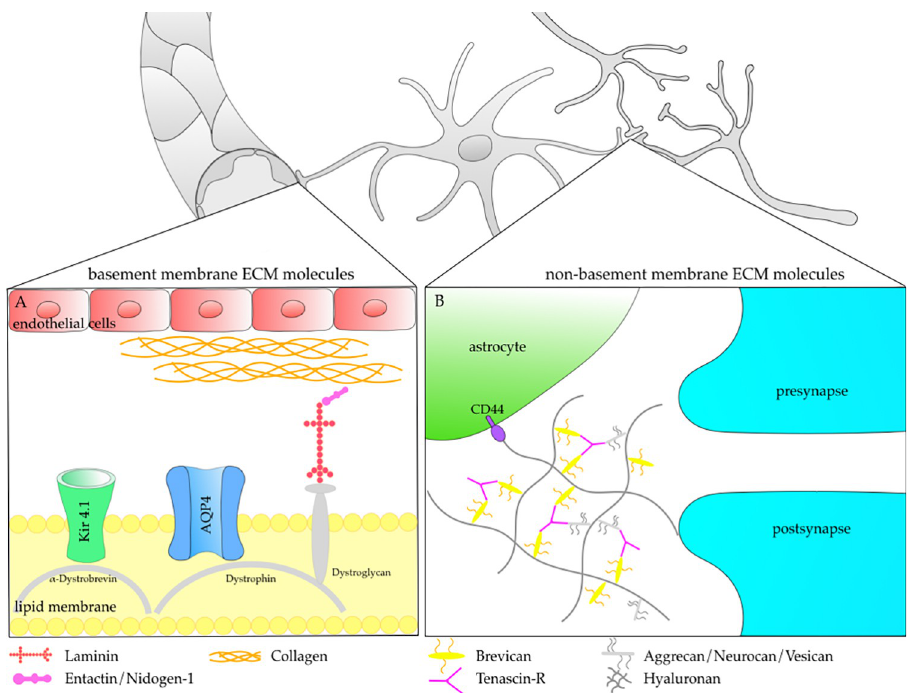
Fig 1. Localization and function of basement membrane and non-basement membrane extracellular matrix (ECM) molecules. Detailed view ( A ) shows basement membrane ECM molecules like laminin, entactin/nidogen-1 and collagen. Laminin interacts within the dystroglycan-dystrophin-dystrobrevin complex to ensure anchoring and stabilization of the aquaporin 4 (AQP4) water channel as well as the inwardly rectifying potassium channel Kir 4.1 in the perivascular basal lamina [32, 33]. Detailed view ( B ) illustrates the participation of non-basement membrane ECM molecules like brevican and tenascin-R in the tripartite synapse. The tripartite synapse consists of a presynaptic and postsynaptic membrane as well as a closely apposed astrocyte process [44]. By connection to further ECM components (hyaluronan, aggrecan, neurocan, vesican) tenascin-R and brevican form perineuronal nets (PNN). Anchored via the cell-surface glycoprotein CD44, PNNs are presumed to play a role in synapse stability and plasticity